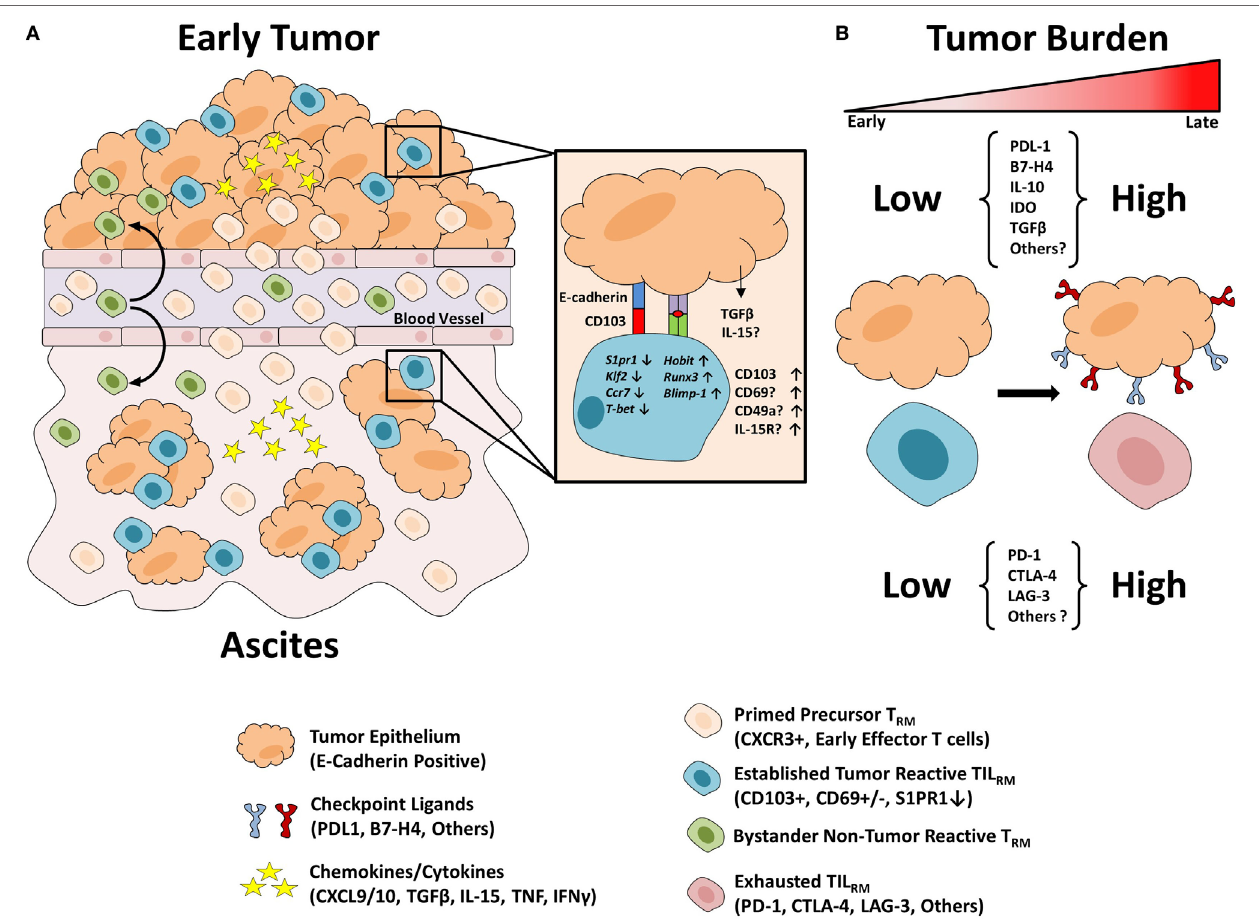
FiGURe 1 | Proposed model of TIL RM formation. (A) Precursor resident memory T cells (T RM ) populations are composed of previously activated CXCR3 + T cells which are attracted to the chemokines CXCL9/10 in the inflamed tumor environment. Within the epithelial tumor tissue, cells encounter TGF- β which promotes CD103 expression. In response to TCR engagement cells may express increased CD69 which in turn disrupts S1PR1 expression leading to a breakdown in the chemoattractant signal from S1P concentrations in the blood. TIL RM cells bind to their target tumor cells with increased strength due to CD103 binding to its ligand E-cadherin, thus promoting their residency in the epithelial tissue. Similarly, precursor T RM may traffic to the inflamed ascites environment and interact with epithelial tumor cells leading to TIL RM formation. Finally, bystander precursor T RM populations may traffic to the inflamed tumor and/or ascites environment and develop T RM -like characteristics but with irrelevant antigen specificity. (B) Throughout cancer progression, the tumor microenvironment becomes increasingly inhospitable with increased tumor burden. Tumor cells upregulate immunosuppressive checkpoint receptors to avoid immune eradication. Following T cell activation and prolonged antigen stimulation T cells upregulate a variety of immune checkpoints which act to suppress anti-tumor immunity. TIL RM may be inhibited due to the high expression of such checkpoint receptors and thus are likely candidates to respond to immune checkpoint blockade